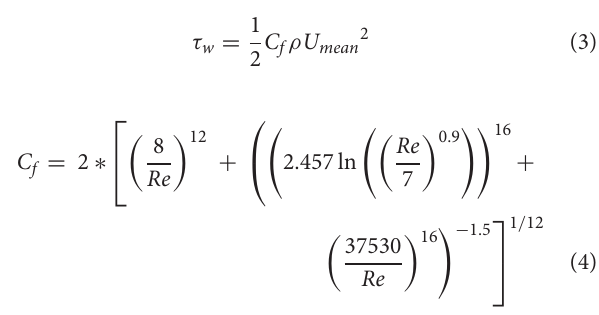
( Table 2 ), and C f is the skin friction coefficient calculated per Equation (4)